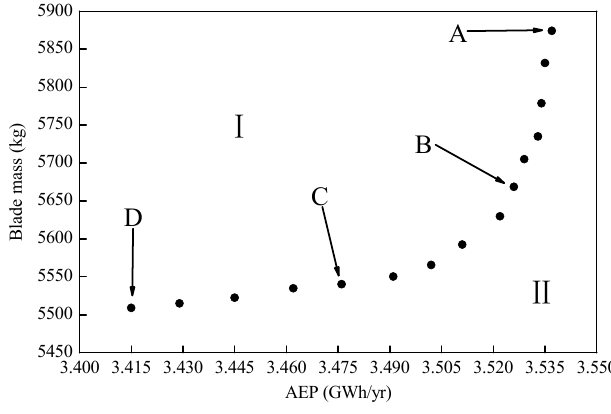
Figure 13. Pareto front of two objectives. Table 5. Values of the design variables.